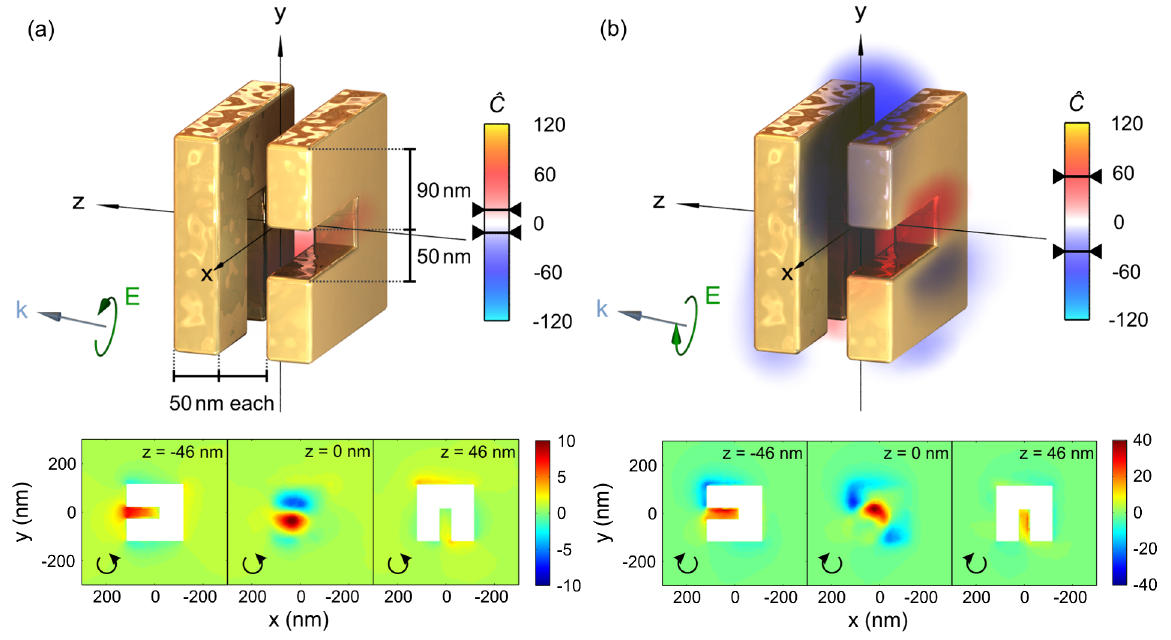
FIG. 11. Optical chirality enhancement induced by the stereometamaterial with (a) LCP and (b) RCP as incident polarizations at wavelength 1 : 34 (cid:1) m . Note that the enhancement is strongest when the handedness of the light is opposite to the handedness of the structure. The strongest enhancement can be observed in the middle of the layer between the two split-ring